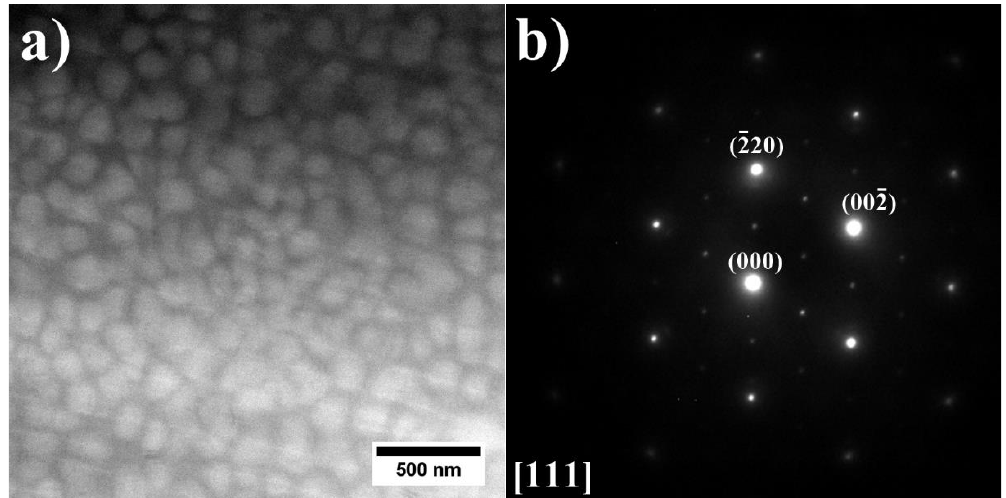
Figure 15. ( a ) Morphology of the γ’ precipitates in dendritic region; ( b ) corresponding SAED pattern. STEM-HAADF.